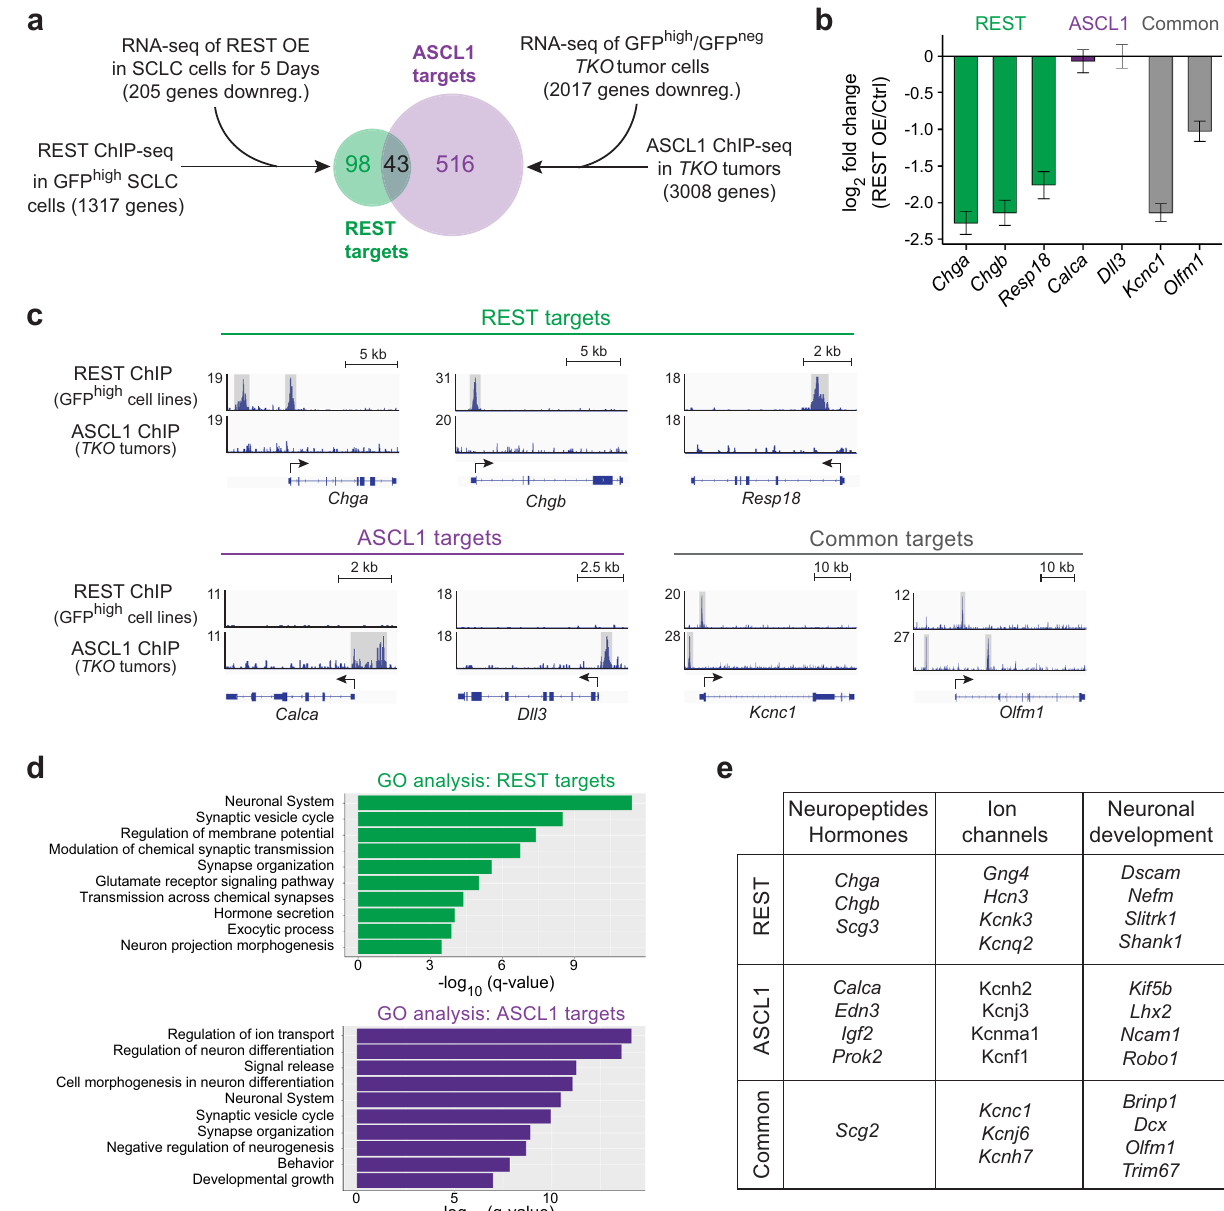
Fig. 2 REST and ASCL1 control largely non-overlapping programs in SCLC cells. a Experimental work fl ow to identify REST and ASCL1 candidate target genes. GFP high cells are non-NE SCLC cells from TKO ; Hes1 GFP/ + tumors while GFP neg cells represent NE SCLC cells. The mouse SCLC cell line used for the RNA-seq of REST overexpression (OE) is the neuroendocrine KP1 cell line. b Expression of selected neuroendocrine and neuronal-related genes from RNA- seq data of 5-day REST overexpression ( n = 3). Error bars, log2 fold change estimate ± SE. c ChIP-seq data showing REST and ASCL1 binding near/within their respective target genes in ( b ). d Gene ontology (GO) analysis of candidate REST and ASCL1 targets. Note the similar GO terms between the two factors. e Examples of REST, ASCL1 and shared target genes in different gene categories. See also Supplementary Figs. 3 and 4 and Supplementary Data 3 –